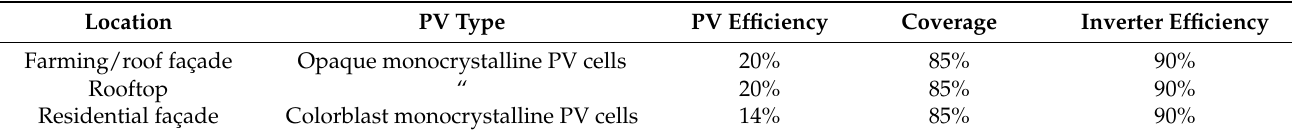
Figure 7. BIPV allocation of Europoint complex. Table 5. Parameters of BIPV simulation.